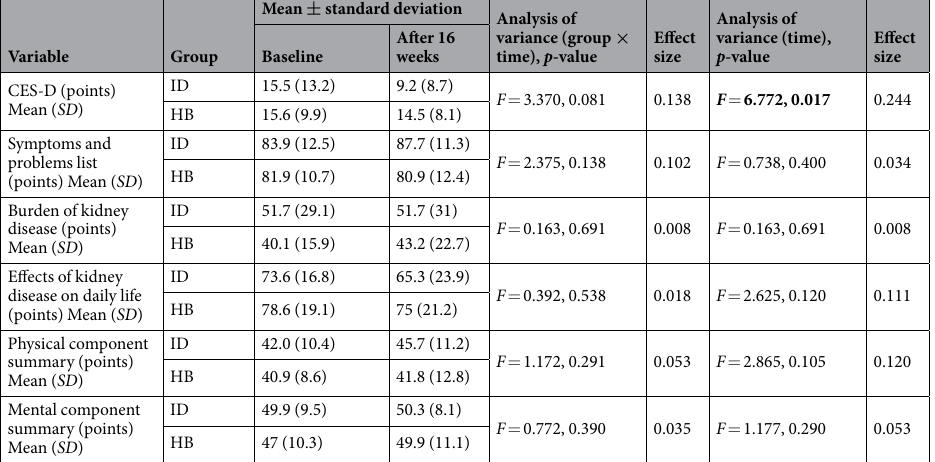
Table 4. Mixed-model of repeated measures for depression and health-related quality of life. CES-D: Center for Epidemiologic Studies Depression